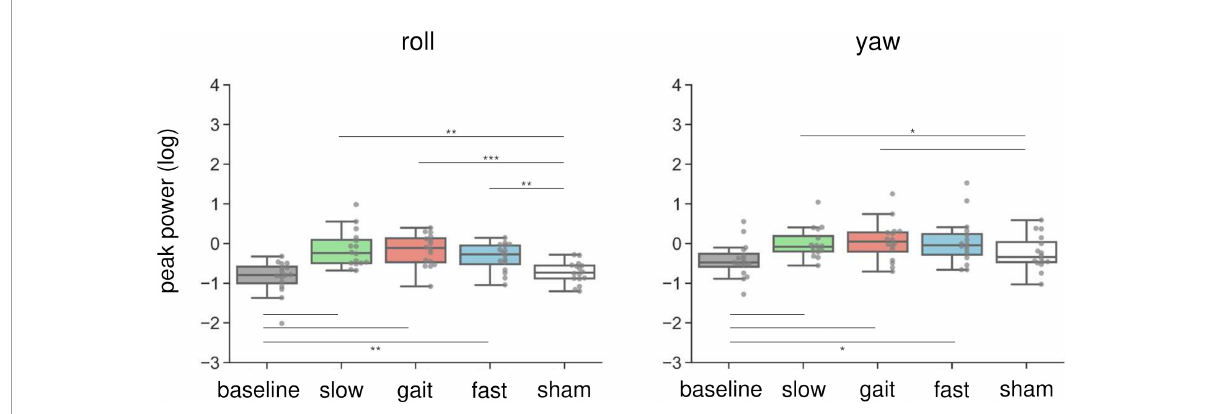
FIGURE4 Effects of AC-GVS on peak power in each motion direction (roll, left; yaw, right) in Experiment 1. Peak power data were collapsed over the imagery and no-imagery sessions. Box plots show the 25th to 75th percentile, with the median shown as a horizontal line. Each dot indicates the peak power in each stimulation condition for one participant. AC-GVS at all frequencies increased the roll peak power compared with the baseline and sham conditions, while the yaw peak power was enhanced by AC-GVS at the slow and gait frequencies. * p < 0.05, ** p < 0.01, *** p < 0.001.